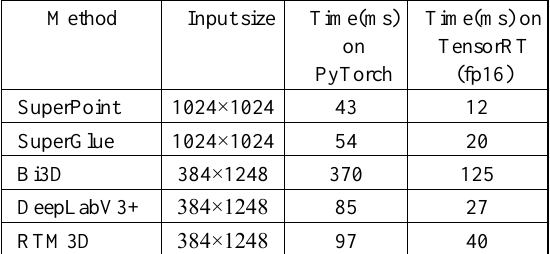
Table 1. Inference time models on PyTorch and NVIDIA